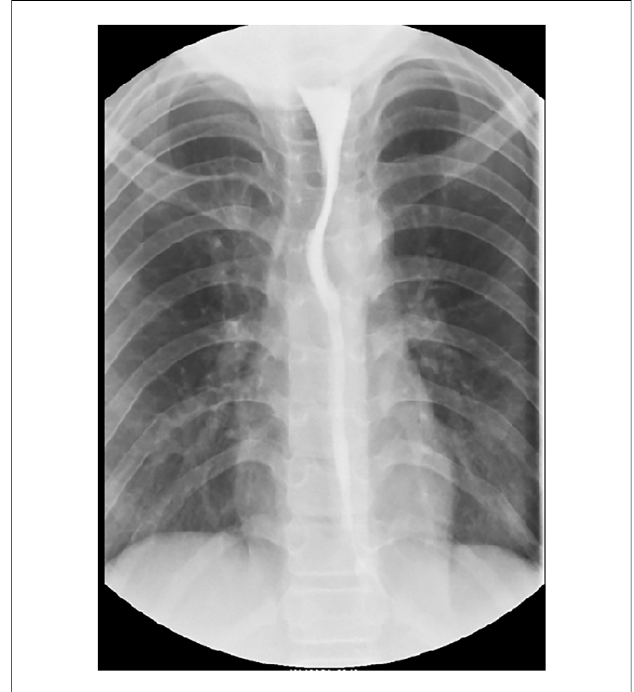
FIGURE 1 Upper gastrointestinal radiography showed diffusing contraction of the lower